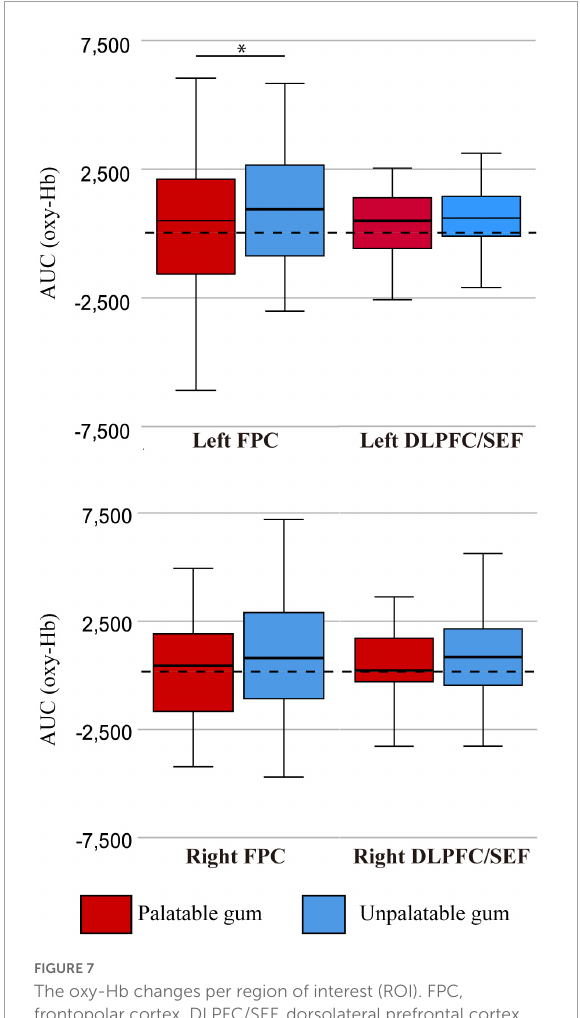
FIGURE7 The oxy-Hb changes per region of interest (ROI). FPC, frontopolar cortex, DLPFC/SEF, dorsolateral prefrontal cortex and includes frontal eye fields. AUC (oxy-Hb), mean area under the curve (AUC) of oxy-hemoglobin of the channels in each regions of interest. ∗ There was a statistically significant difference between the palatable gum and the palatable gum by multiple comparison using Wilcoxon signed-rank test ( p -values were